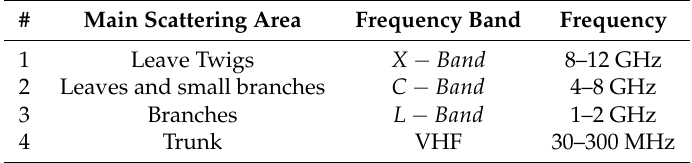
Table 5. Tree elements correspondence to the frequency of different radar